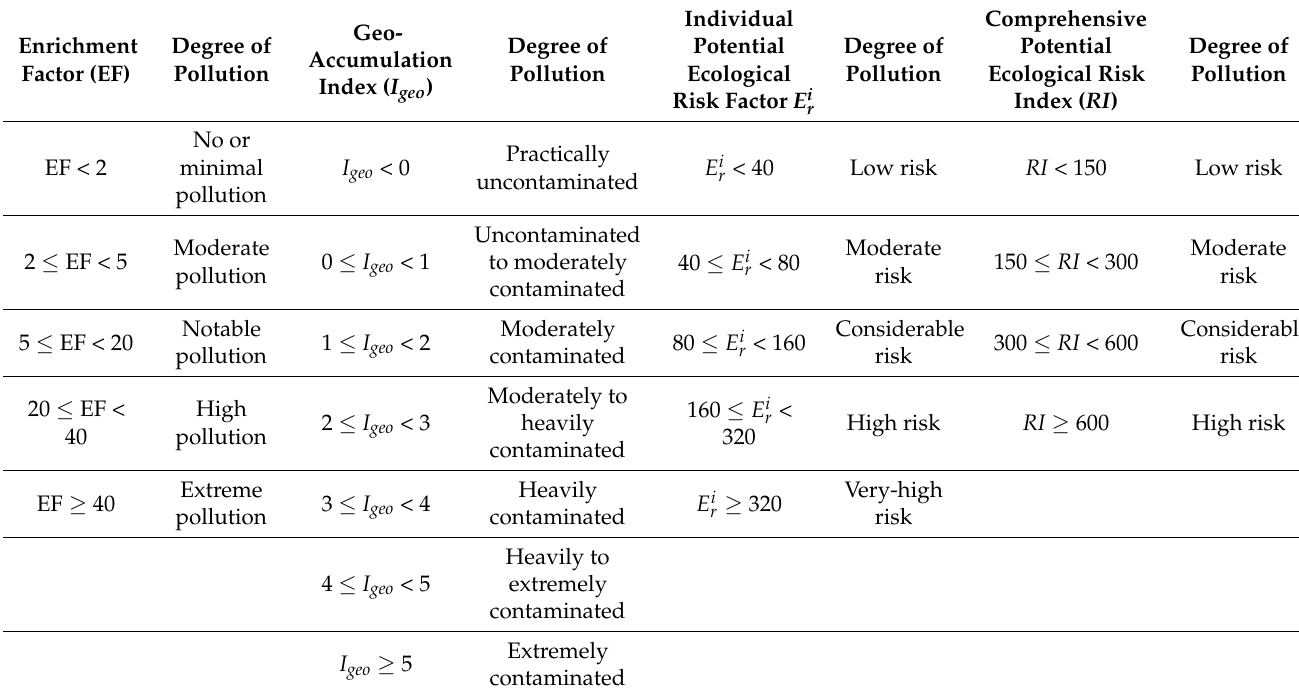
Table 1. Geo-accumulation index [27], enrichment factor [29], individual potential ecological risk factor E i r and comprehensive potential ecological risk index ( RI ) [30] level criteria